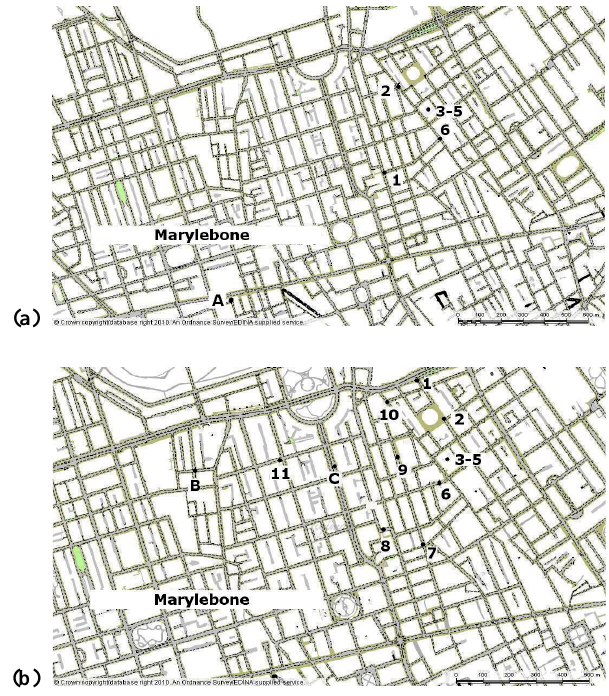
Fig. 1. (a) Experimental setup for the REPARTEE I. Source loca- tions: A Receptor locations: 1 to 10. Note: receptors 3 to 5 located at heights 1.5m, 160 and 190m on BT Tower. (b) Experimental setup for the REPARTEE II. Source locations: B and C Receptor locations: 1 to 10. Note: receptors 3 to 5 located at heights 1.5m, 160 and 190m on BT